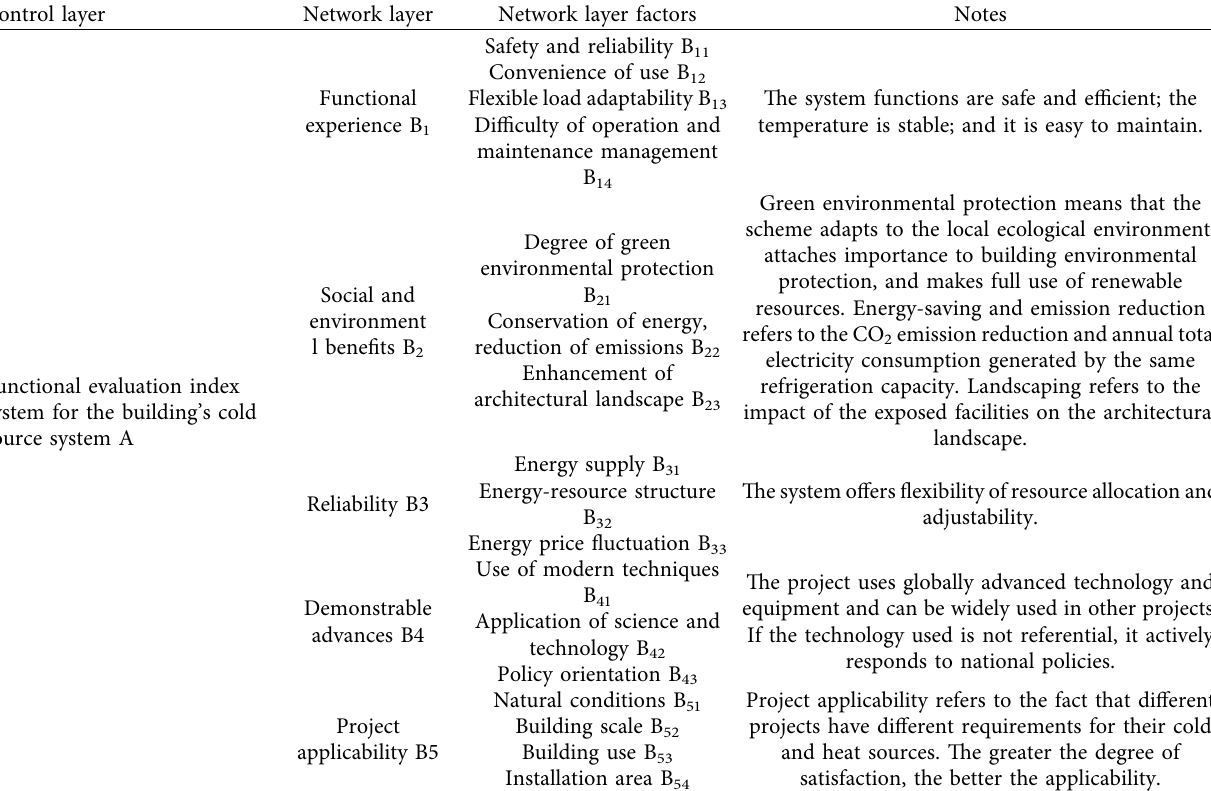
Table 1: Functional evaluation index system and